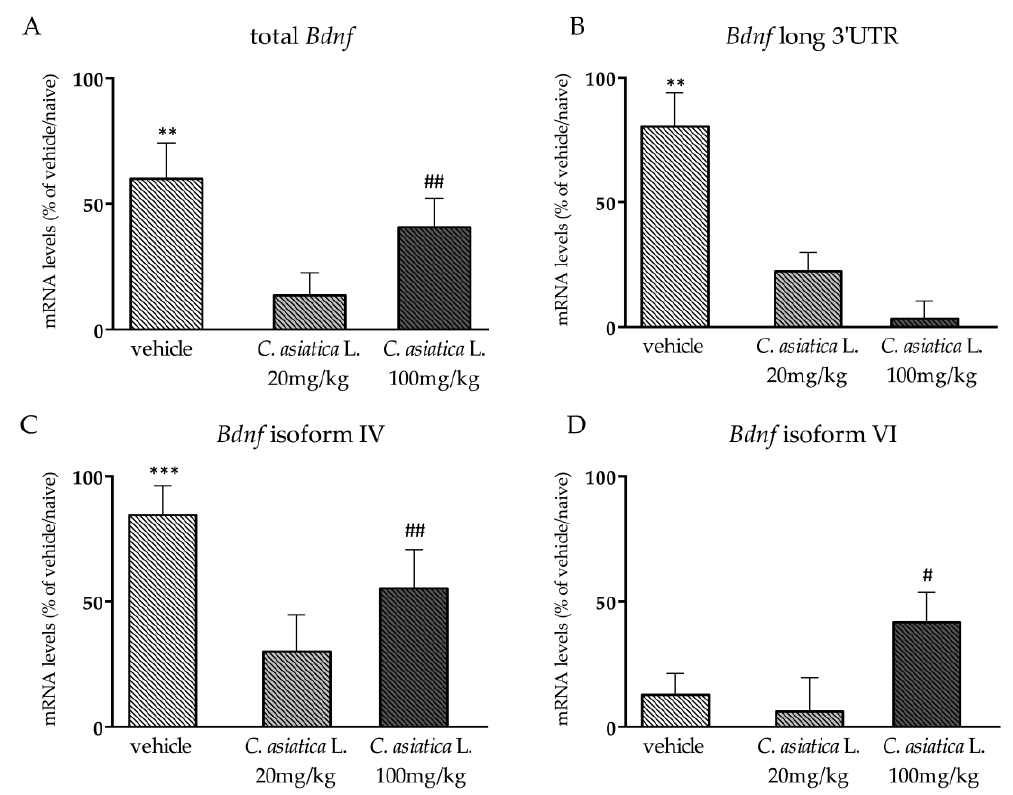
Figure 6. Analysis of total Bdnf ( A ), Bdnf long 3′ UTR ( B ), Bdnf isoform IV ( C ), and Bdnf isoform VI ( D ) mRNA levels in the prefrontal cortex of rats that were chronically treated with 20 or 100 mg/kg of C. asiatica L. and exposed to the novel object recognition (NOR) test. The data are expressed as percentage change of naïve group of each treatment (set at 100%) and are represented as mean ± SEM of at least five independent determinations. ** p < 0.01; *** p < 0.001 vs vehicle, # p < 0.05; ## p < 0.01 vs C. asiatica L 100 mg/kg (two- way ANOVA with Fisher’s PLSD)